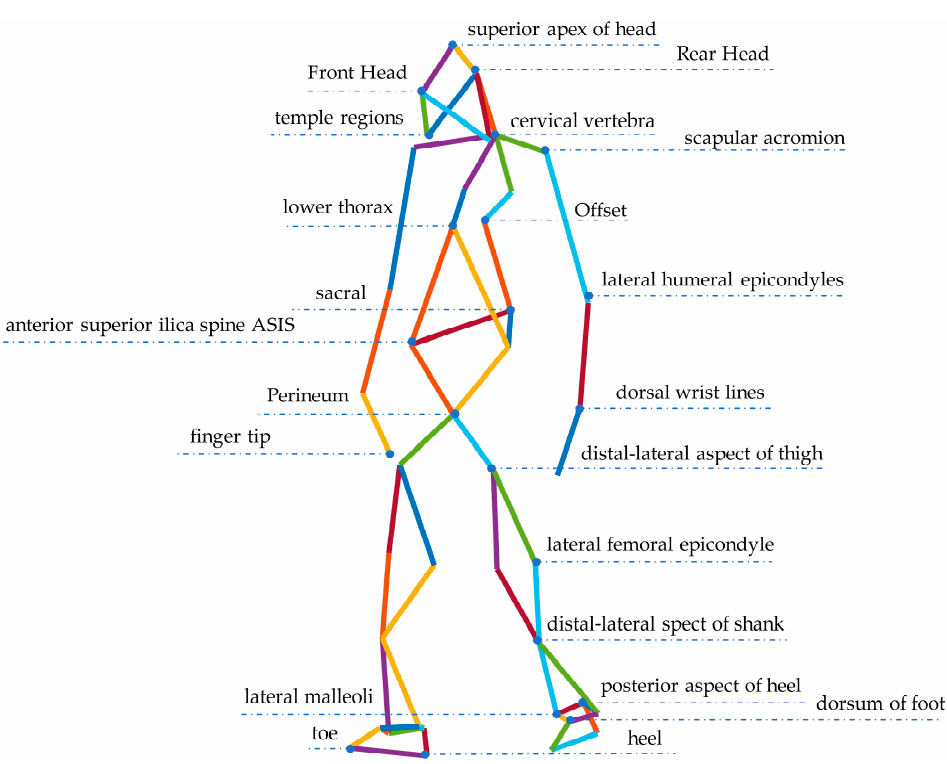
Figure 1. 42-Markers model. (Some of the markers in this calibration model are symmetric and identified separately in Figure 1; the non-symmetric markers are identified